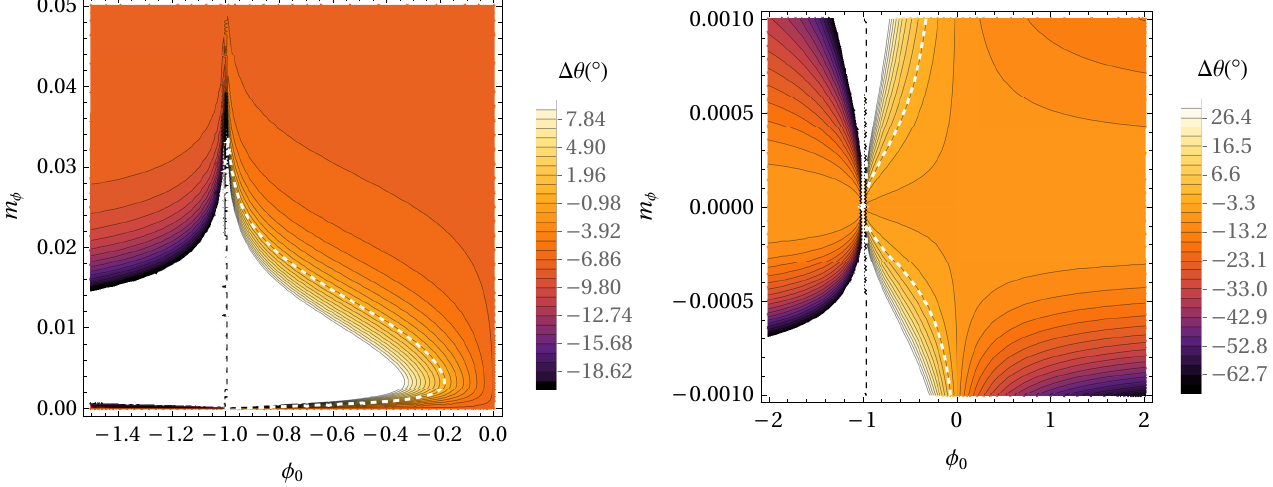
Figure 6. The same as in Figure 5, but for the mass density distribution ρ 0 = 4 × 10 8 M (cid:12) pc − 3 . The right panel represents the same as the left panel but for smaller values of the m φ